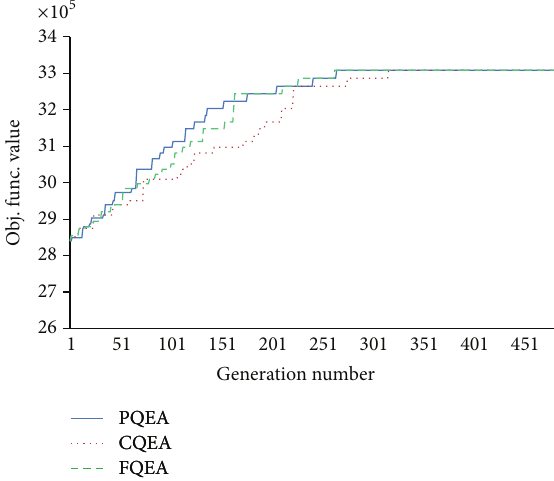
Figure 6: Convergence graph of PQEA, CQEA, and FQEA on COUNTSAT problem size, 𝑛 , being 50.